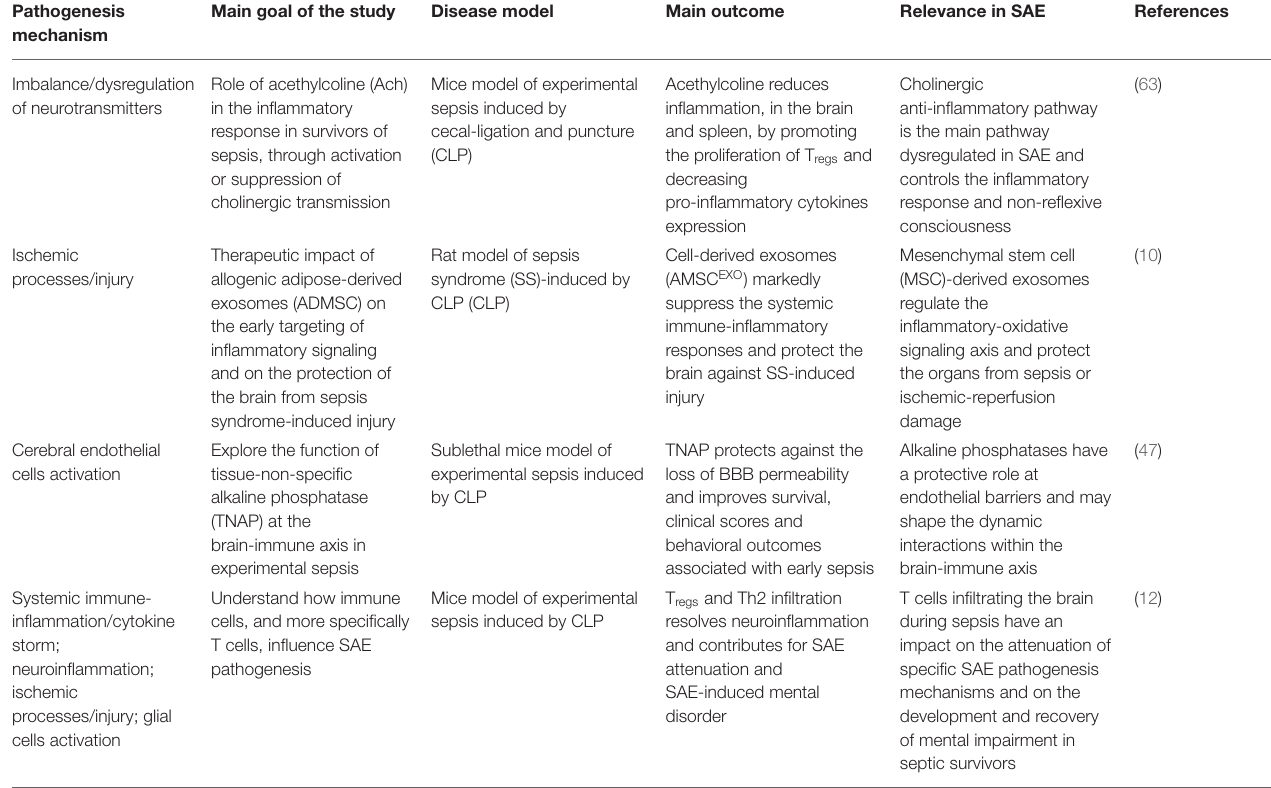
TABLE 2 | Mechanisms of T regs in